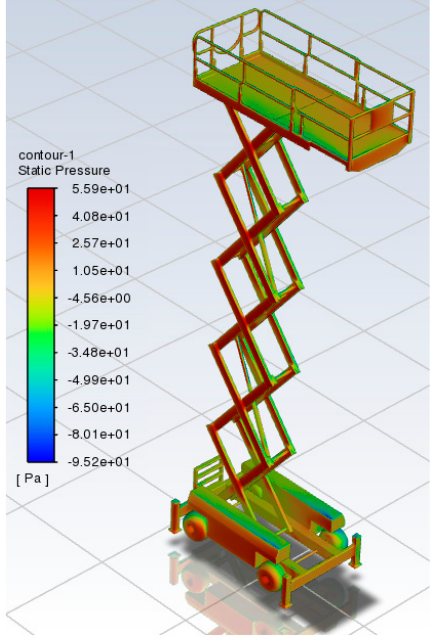
Figure 9. The exemplary distribution of the static pressure ( β = 30°).